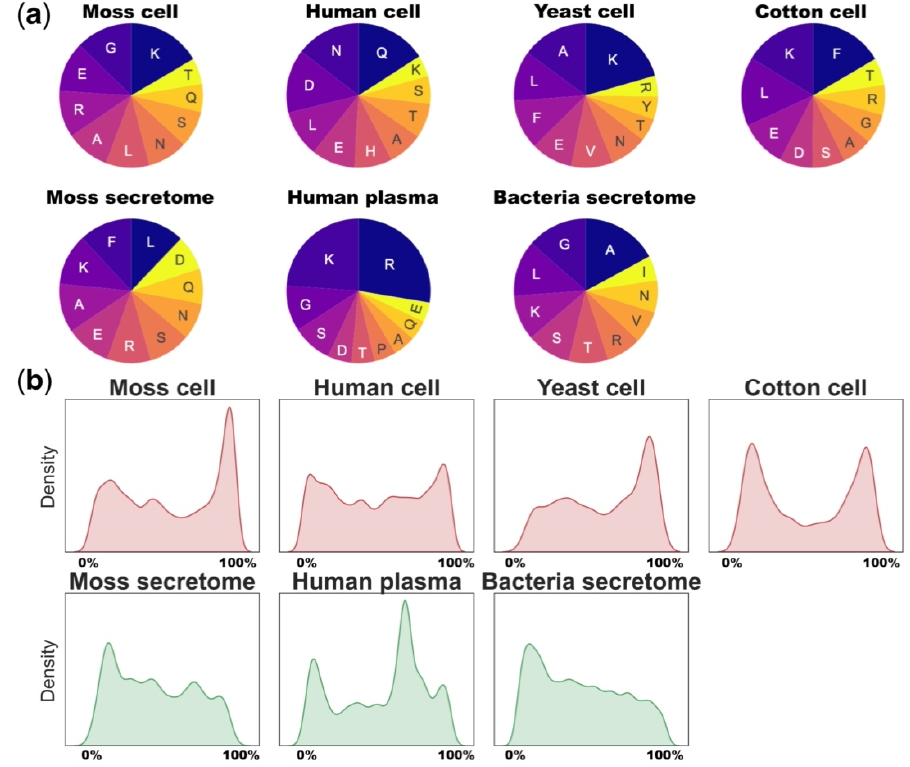
Figure 2. The peptidome degradation patterns. ( a )—Pie chart showing the top 10 amino acids at the C-terminal positions of intracellular peptides from moss [15], human [64], yeast [65], cotton [62] and extracellular peptides from human plasma [12], moss [15,16] and bacteria [63]; ( b )—Density plot showing the distribution of MS-identified peptides across the precursor lengths in peptidomic datasets from moss [15,16], human [12,64], yeast [65], cotton [62] and bacteria [63]. The positions of each identified peptide were normalized to protein lengths and represented as percentages. The steps of visualizing and analysing the data in all figures are available in the GitHub code repository: https://github.com/IgorFesenko/Peptidome_review.